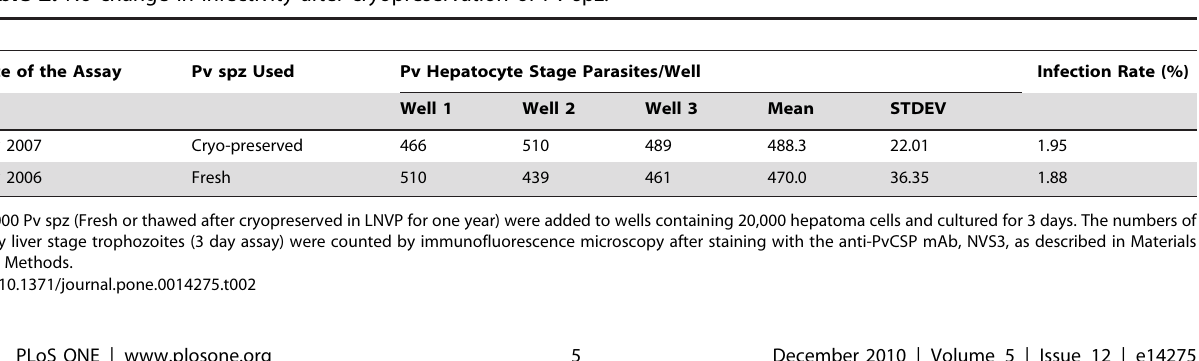
Days in Culture